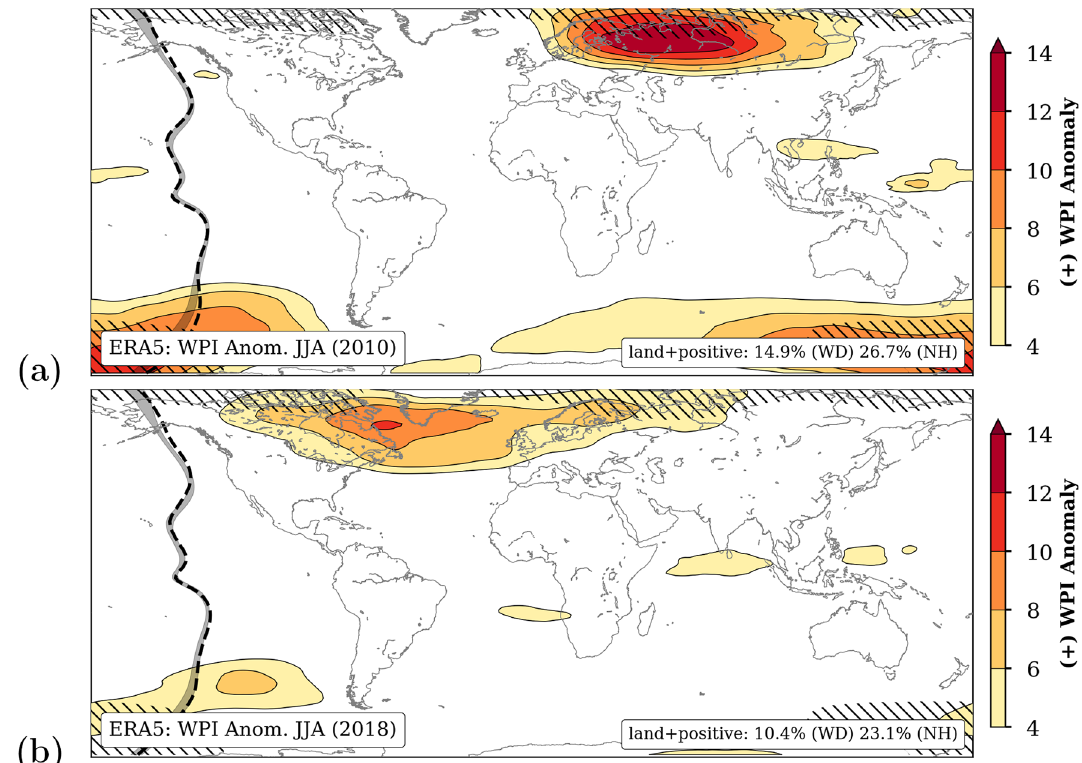
Figure 2. Observed anomalies of WPI pattern in Jun–Aug 2010 ( a ) and 2018 ( b ) compared to the long-term average 1981–2010 using ERA5 reanalysis data. Only positive anomalies are shown. The hatched areas are regions where the standard deviation of WPI is larger than 4. The values in the lower right box represent the percentage of grid cells over land showing positive anomalies larger than 4, globally (WD) and north of 30 (NH). The meridional distributions of the zonal mean WPI range ( σ ) for the climatological period (1981–2010) and the respective year are given as grey band and dashed line, respectively. The maps were created by using python3-mpltoolkits.basemap (version 1.2.1, https:// matpl otlib. org/ basem